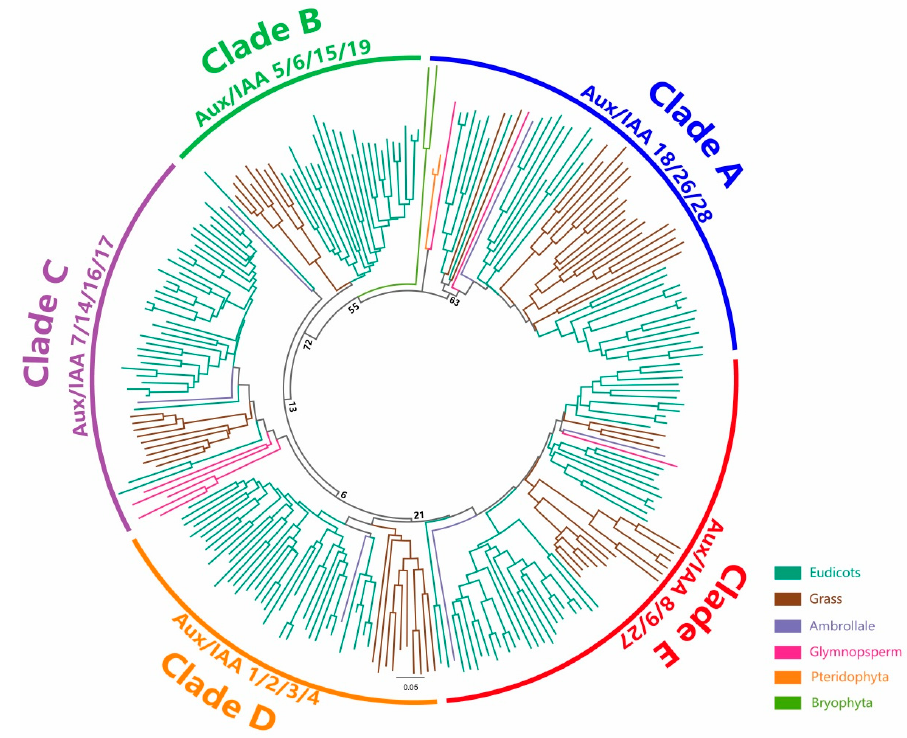
Figure 2. Phylogenetic relationship among canonical Aux/IAA genes. The deduced full-length amino acid sequences of canonical Aux/IAA genes were aligned by ClustalX (2.1), and the neighbor-joining (NJ) tree was constructed by Mega7. The bootstrap values with 1000 replicates are placed on the nodes. The Aux/IAAs derived from different categories are shown in different colors.